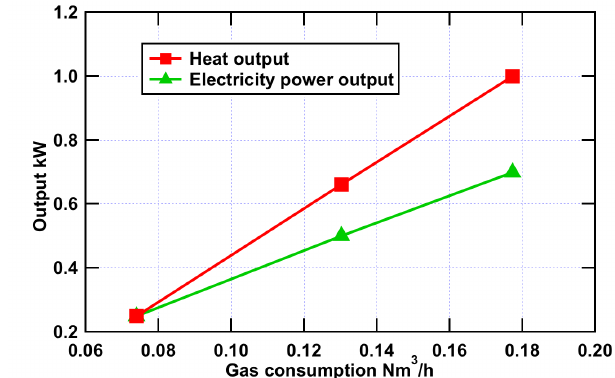
Figure 5. Partial load characteristics of PEFC